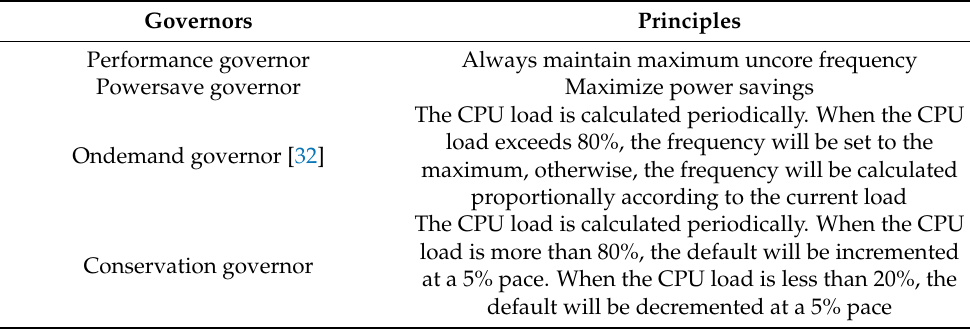
Table 4. Different dynamic power management governors and their principles.